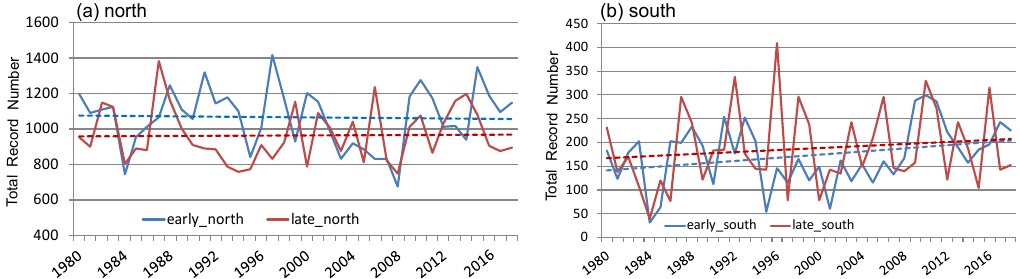
Figure 3. Interannual variation of total cold wave record numbers in ( a ) the northern and ( b ) the southern parts of East China during 1979–2018: The dashed lines show the 40-year